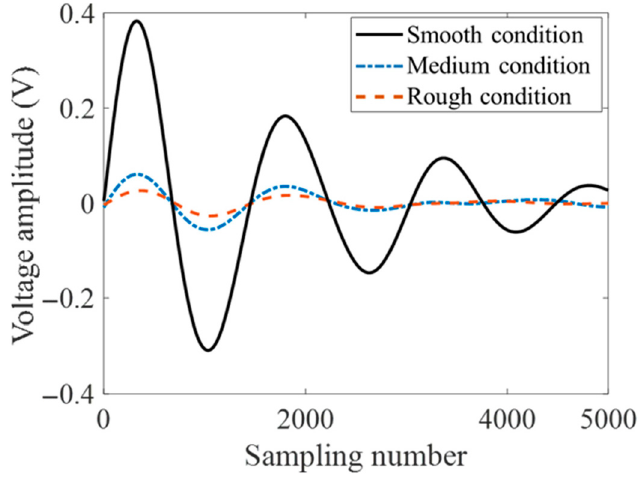
Figure 4. ( a ) Schematic diagram and ( b ) image of the experimental setup.